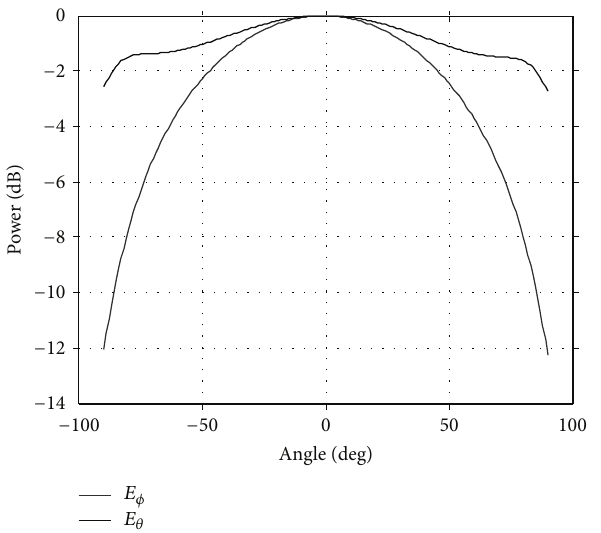
main lobe with 𝐸 𝜃 component showing some ripples in the pattern.